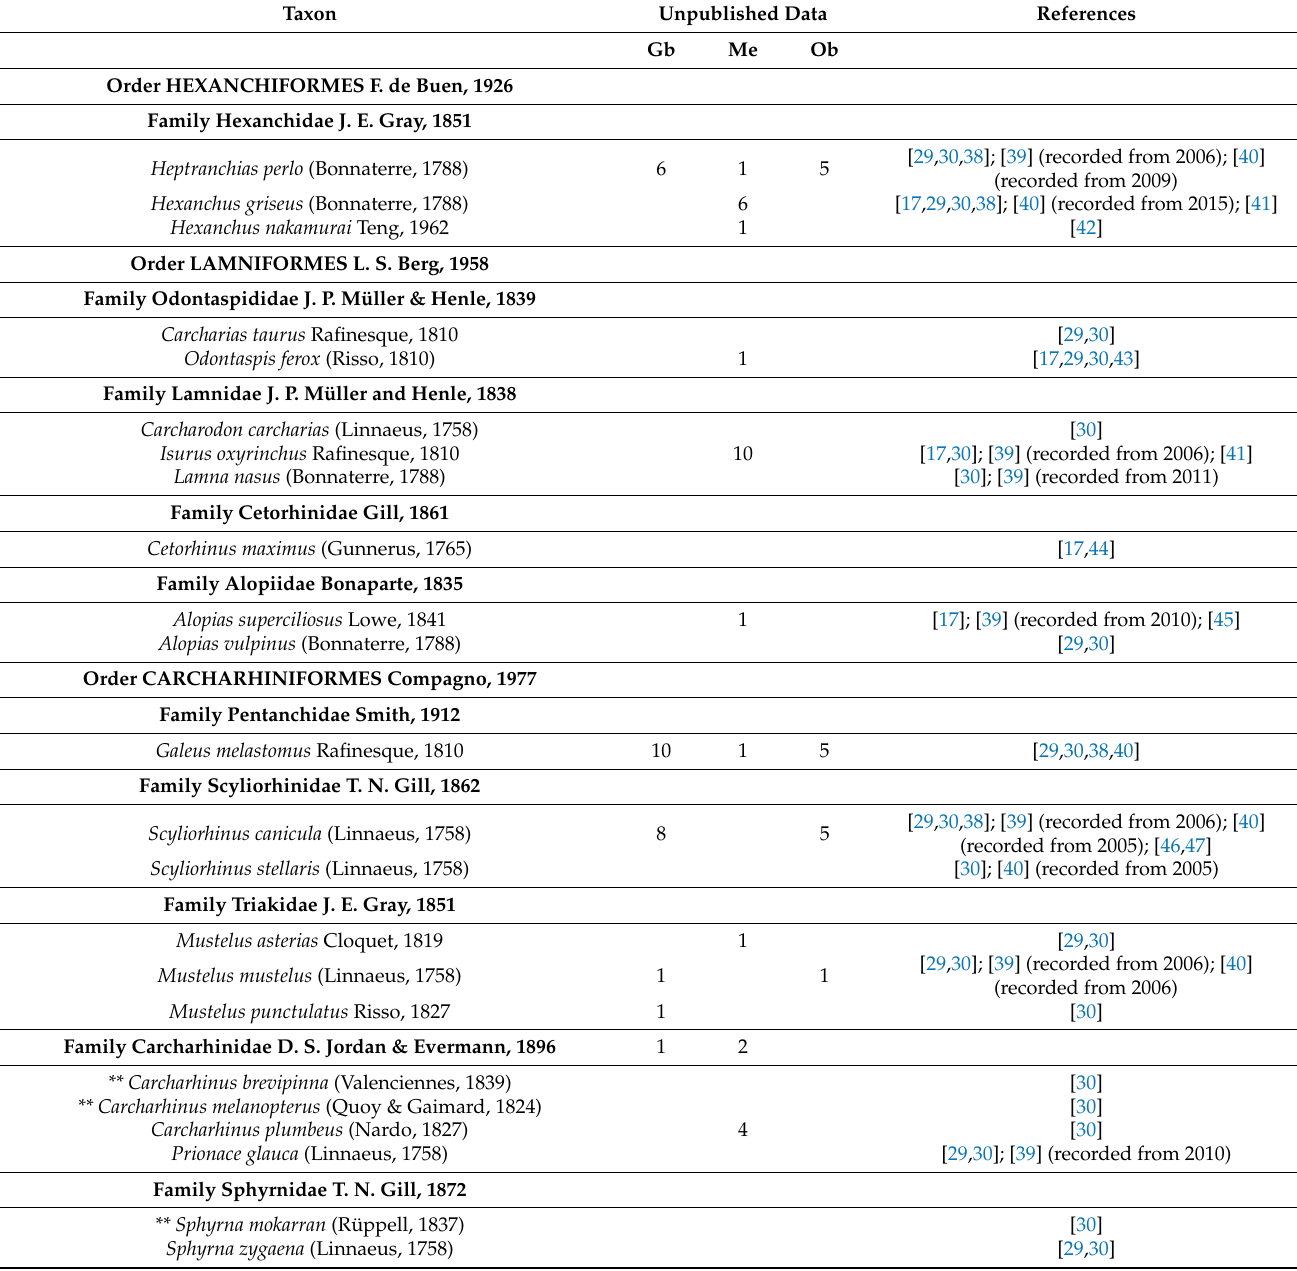
Table 1. Updated checklist of chondrichthyan species recorded from Cyprus (eastern Mediterranean Sea), with number of records obtained through the various unpublished sources (GBIF, Gb; MECO, Me; OBIS, Ob) and references. Abbreviations used: * species newly recorded here; ** species listed with caution. Taxon Unpublished